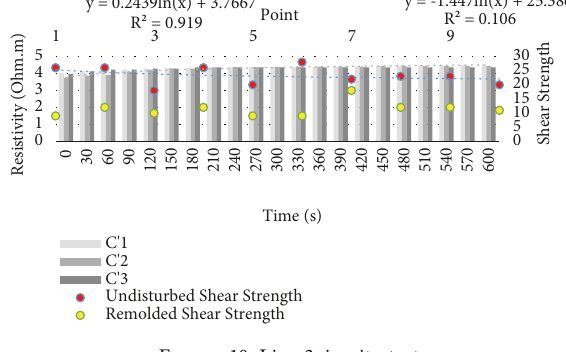
Figure 8: Line 1, in-situ test.